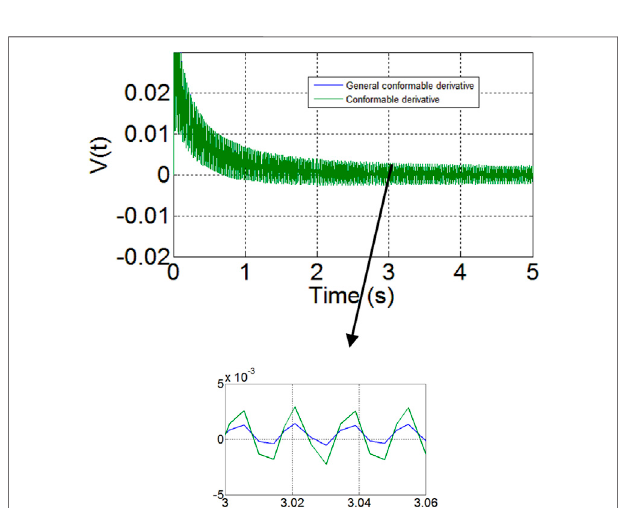
FIGURE 6 | Evolution of V ( t ) with α (cid:2) 0 . 6.